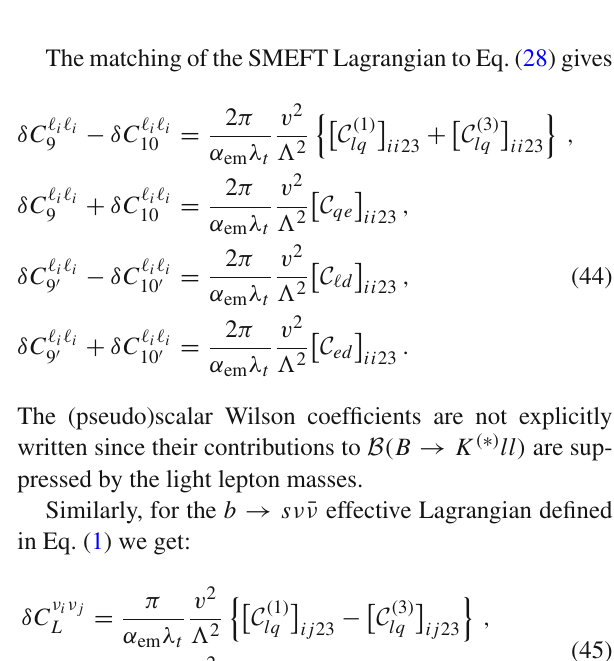
differencebetweenelectronandmuoncoefficientslieswithinthequoted